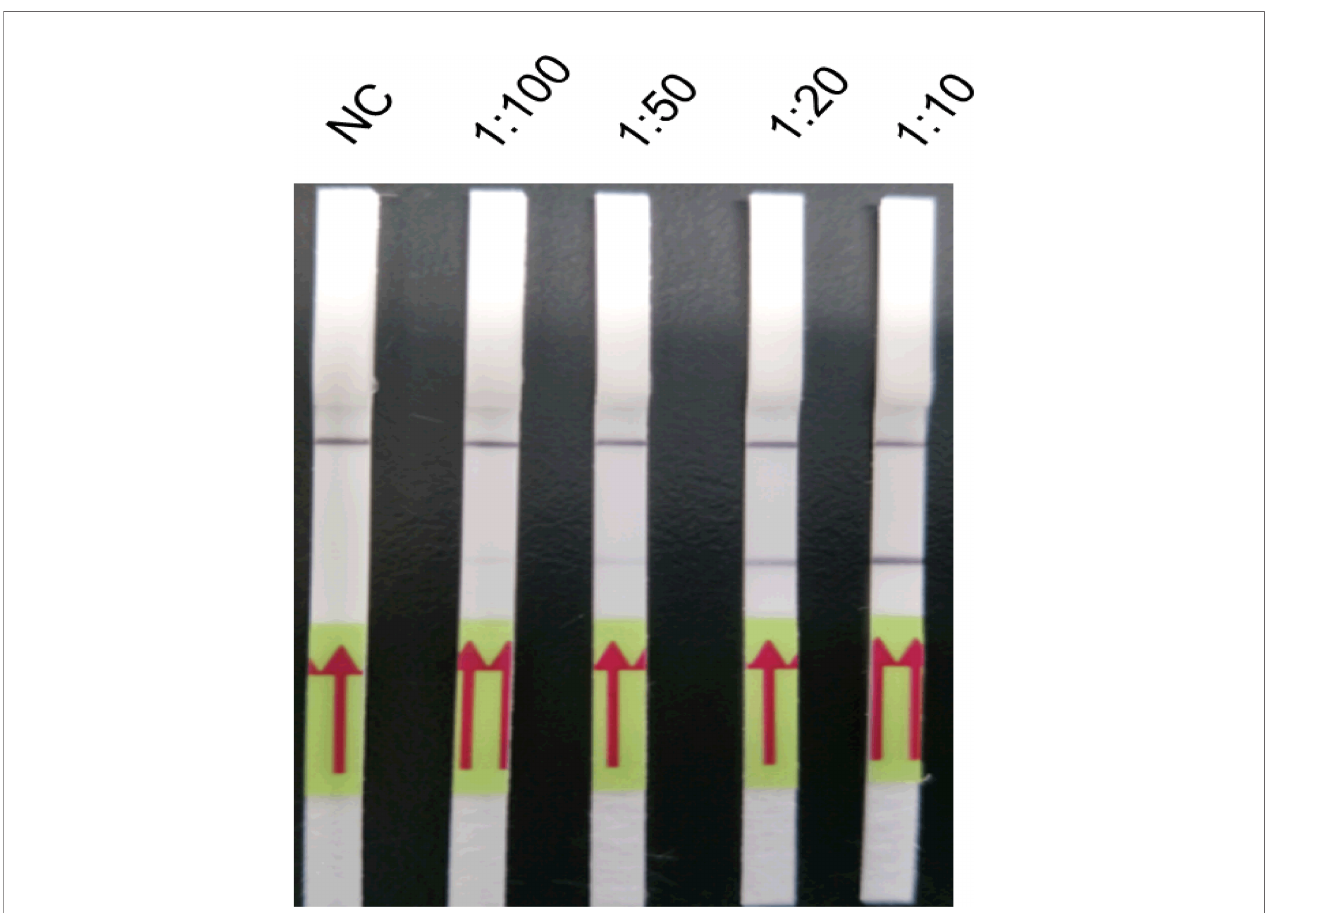
FIGURE 4 | Optimisation of the ampli fi cation product dilution of the LFD-PCR assay. The LFD-RPA assay results are positive at ampli fi cation product dilutions of 1:10, 1:20, 1:50, and 1:100. A clearly visible test band can be observed at 1:10 and 1:20 dilutions, but only a weak test band is visible at 1:50 and 1:100 dilutions. The samples of ampli fi cation product dilutions of 1:10, 1:20, 1:50, and 1:100 were all 2.6 fg/ m l positive plasmid. Negative control (NC), DNA extracted from negative samples and ampli fi cation product in a dilution of 1:10. The red arrows stand for the direction of reaction solution diffusing in the lateral fl ow